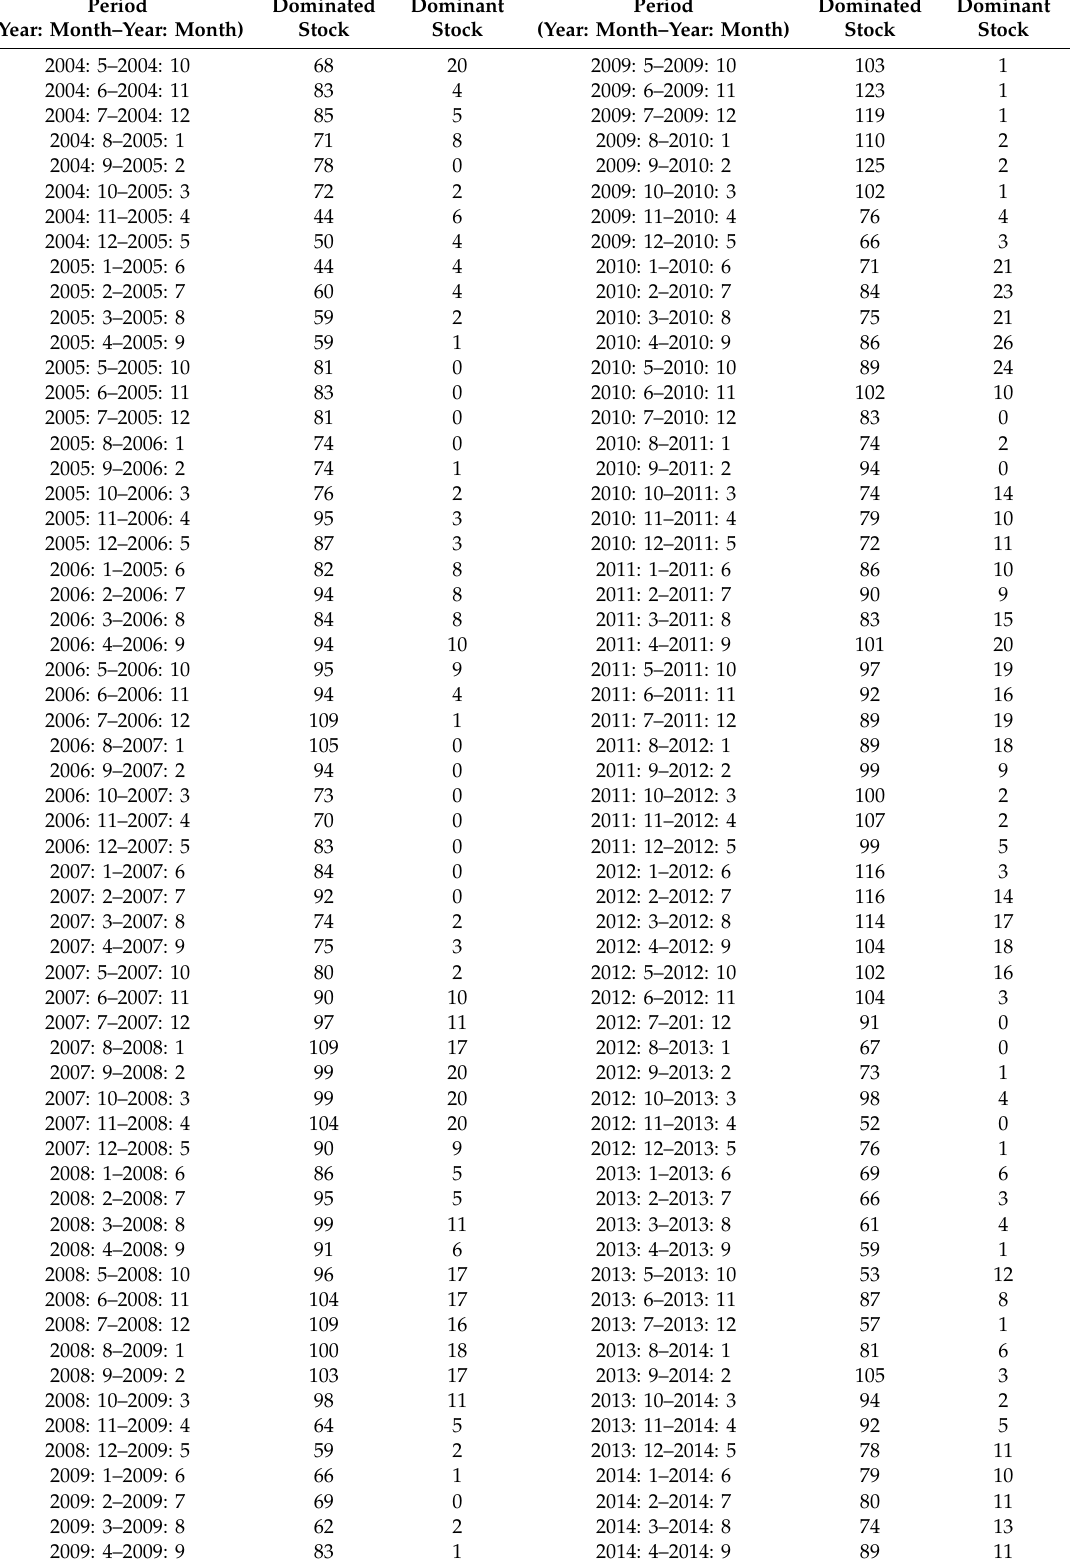
Table 1. The number of dominated and dominant stocks in each six-month